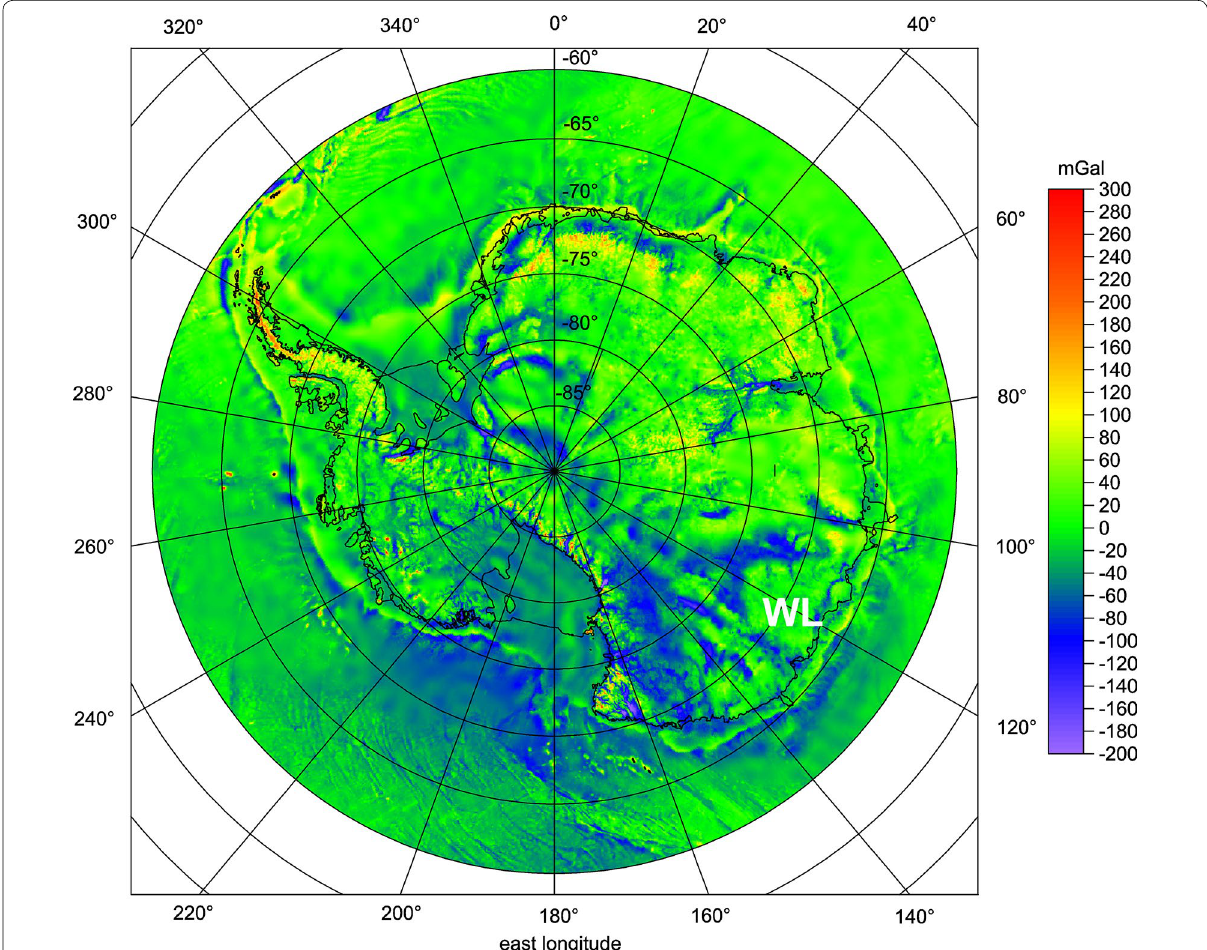
Fig. 1 The values of gravity disturbances Δ g (mGal) for the whole Antarctica. The Wilkes Land (WL) anomaly (between longitudes 100 and 130°E, geodetic latitudes 60 and 75°S) is clearly visible as a semicircular feature with positive anomaly in its center and flanking negative semiring anomaly around, namely from southern directions. For more details see Figs. 7, 8, 9, 10, 11 and